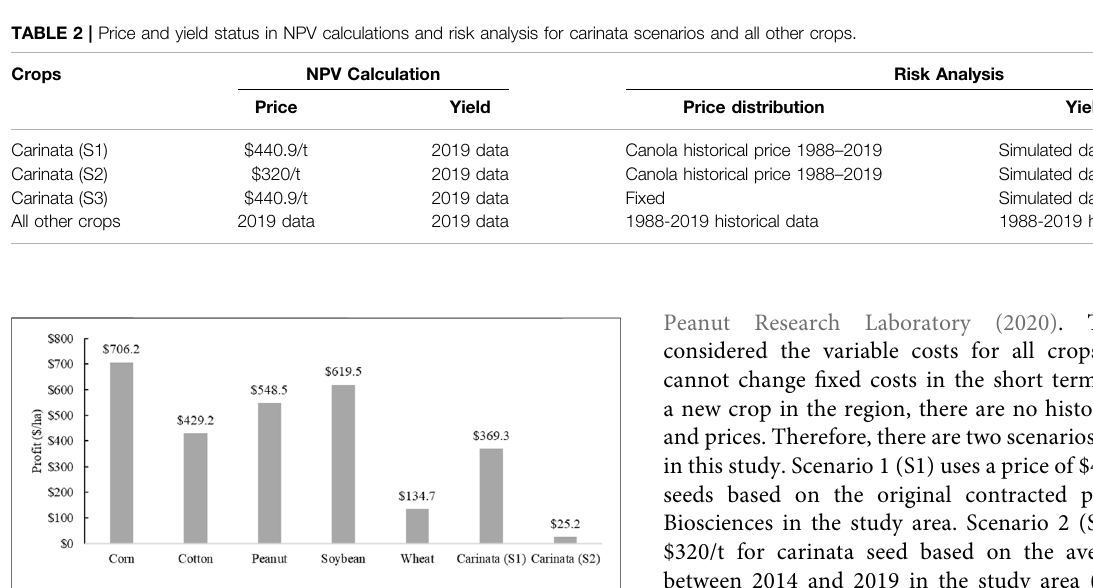
FIGURE 2 | Pro fi tability of selected crops on per unit area basis in South Georgia. ForScenario 1(S1) and Scenario3 (S3), carinata price is $440.9/t. In Scenario 2 (S2), carinata price is $320/t.